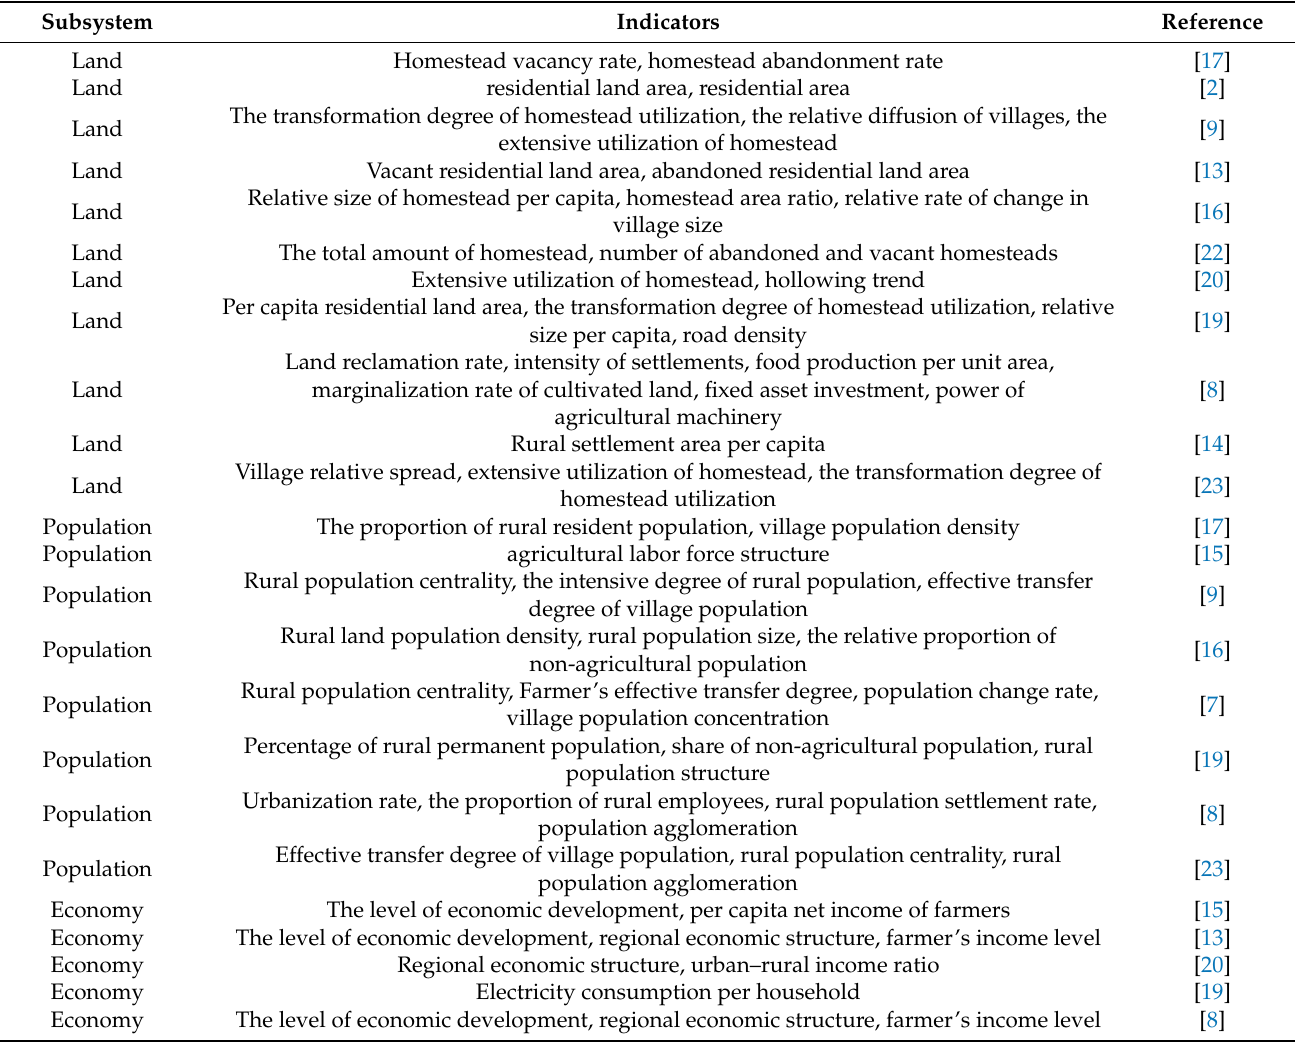
Table 1. Representative indicators of rural